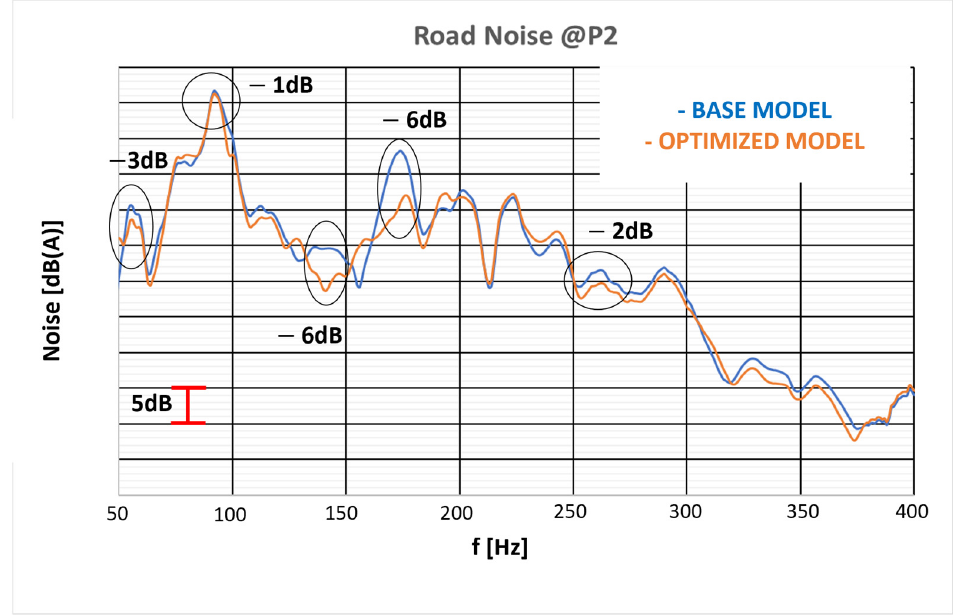
Figure 37. Acoustic pressure on MIC2 (right ear driver) with highlight of the frequency ranges with reduced SPL.